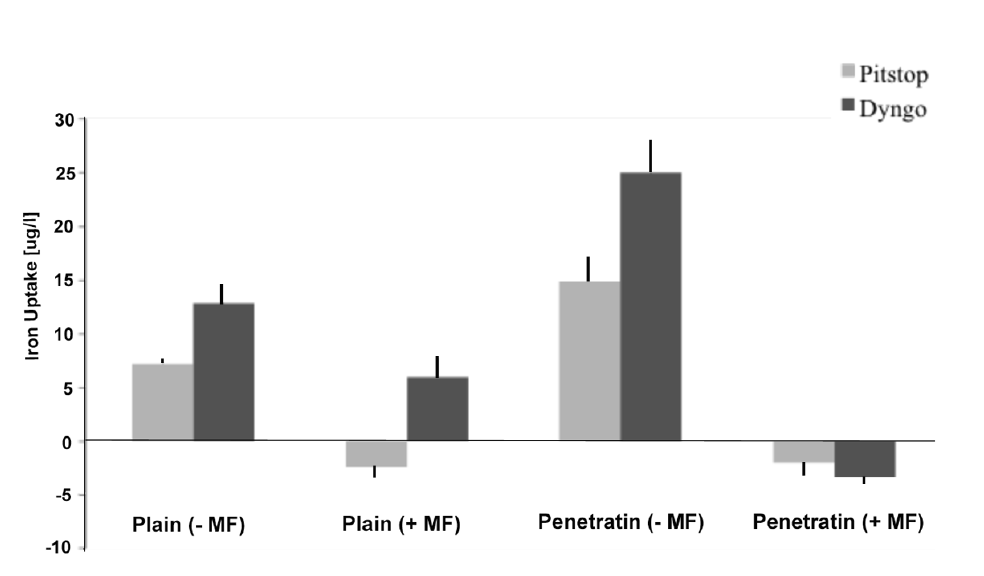
Figure 11. Assessment of NP uptake into cells by ICP-MS levels measured in the cell medium and normalised to control cell cultures (n = 5 from 2 experiments, 